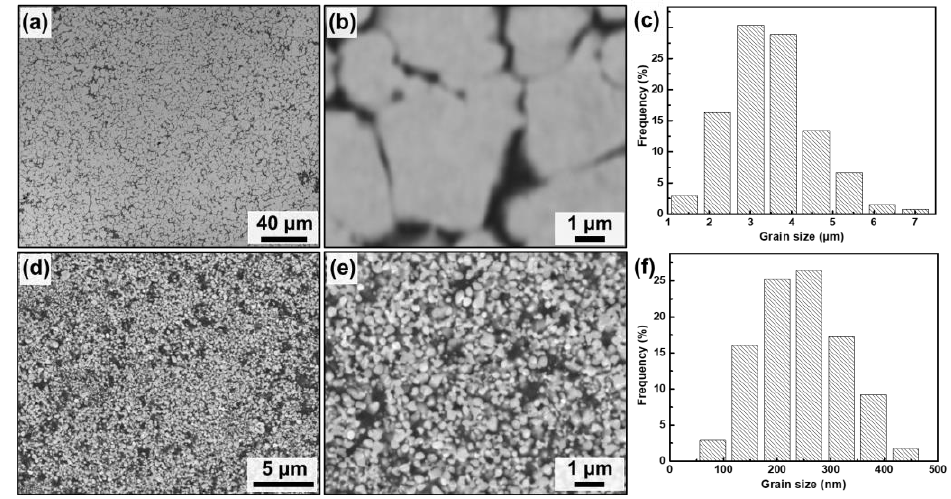
Figure 1. Backscattered SEM images and the corresponding grain size distributions of W in the commercial coarse-grained W – Cu ( a – c ) and UFG W – Cu composites ( d – f ).